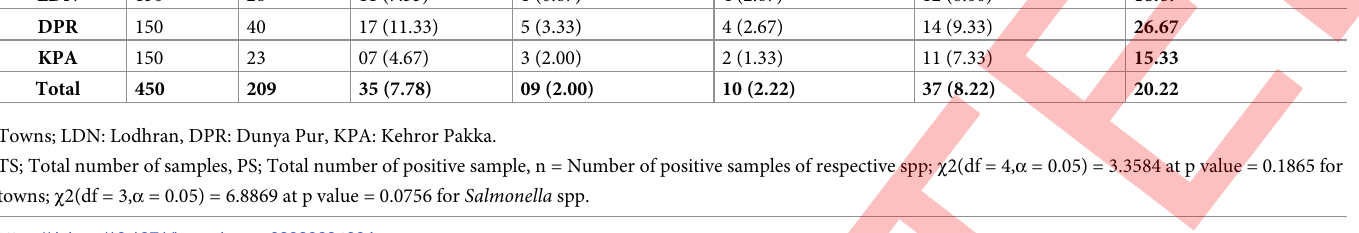
Table 4. Prevalence (%) of Salmonella spp. isolated from raw milk and environment samples in dairy farms from district Lodhran . Towns TS